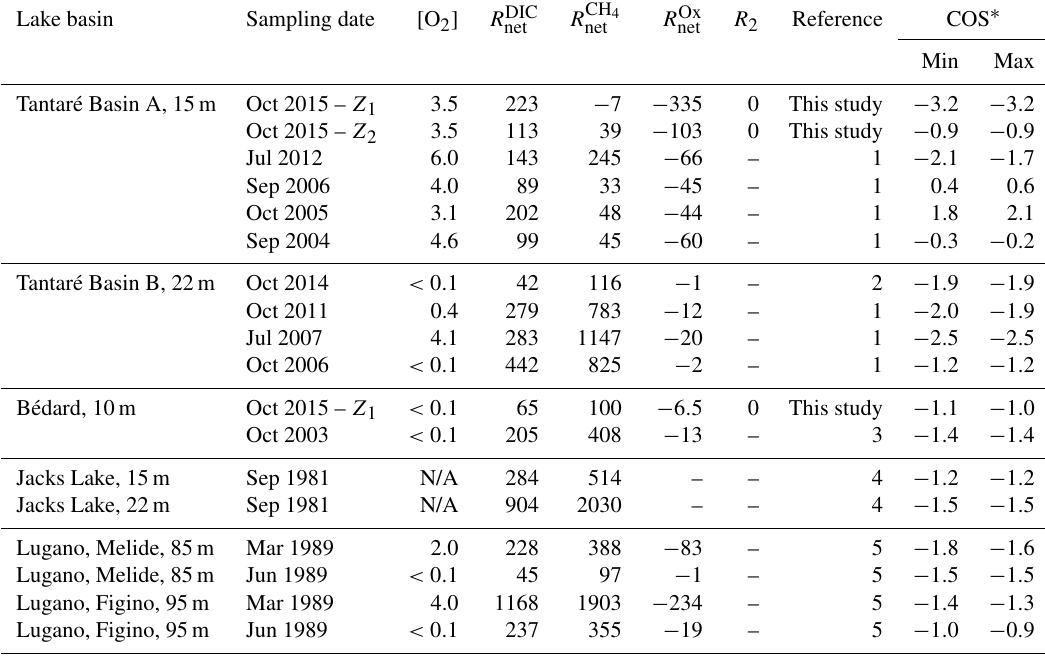
Table 4. Net reaction rates ( R solute net ; fmolcm − 3 s − 1 ) of CH 4 , DIC, and oxidants in the zone with the highest production rate of CH 4 as well as the O 2 concentration in the bottom water ([O 2 ] in mgL − 1 ), the R 2 rates (fmolcm − 3 s − 1 ), and the average carbon oxidation state (COS) of the fermenting OM at the origin of CH 4 calculated with Eq. (9) at both study sites, Lake Tantaré Basin B (Fig. 1), Jacks Lake (Carignan and Lean, 1991), and Lake Lugano (Lazzaretti-Ulmer and Hanselmann, 1999) for various sampling dates. Lake basin